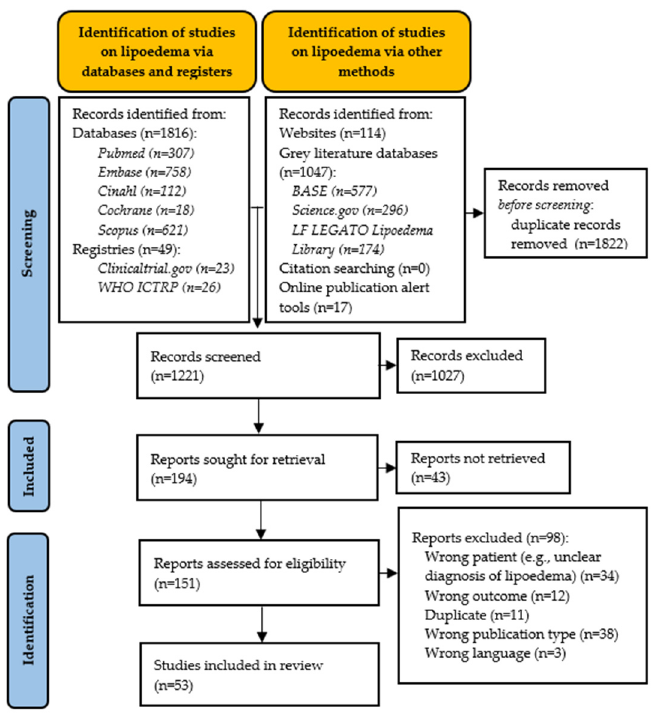
Figure 1. Flowchart search strategy for studies on lipoedema.